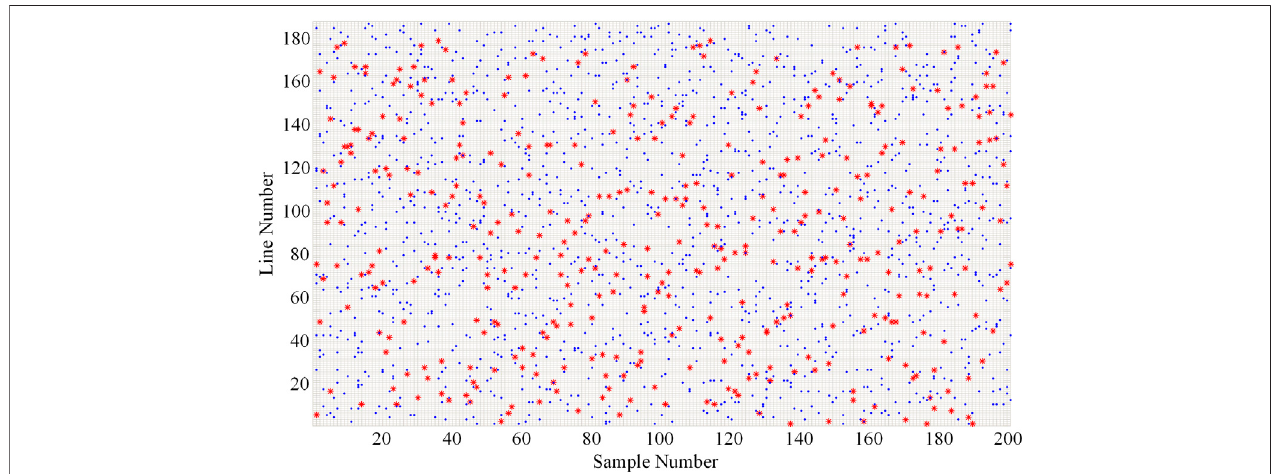
FIGURE 8 | Scatter plot of results of identi fi cation of test samples.